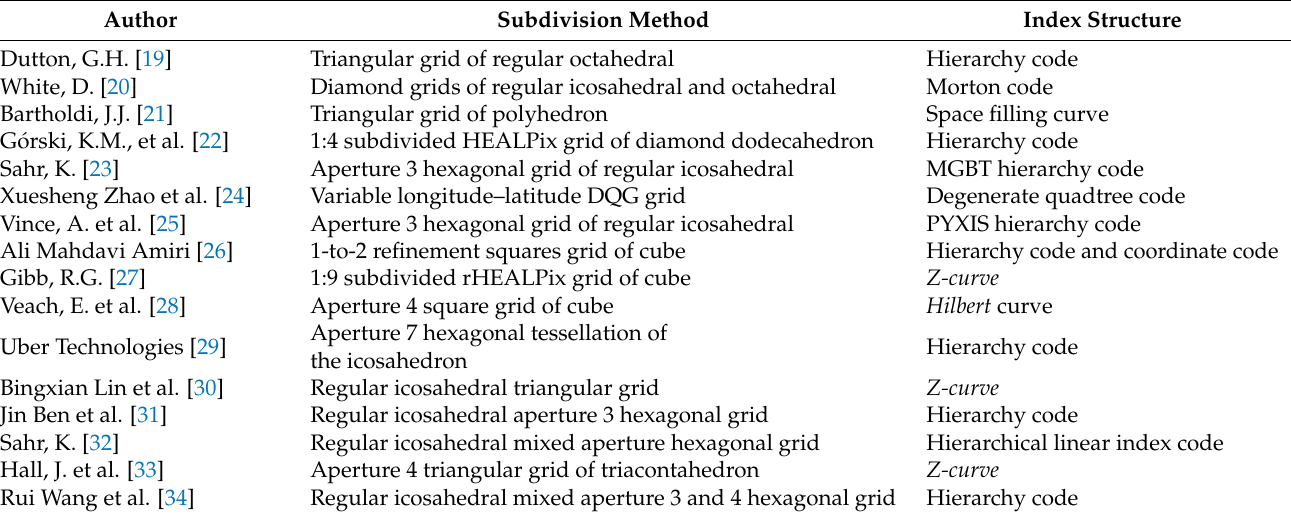
Table 1. Discrete global grid subdivision and index